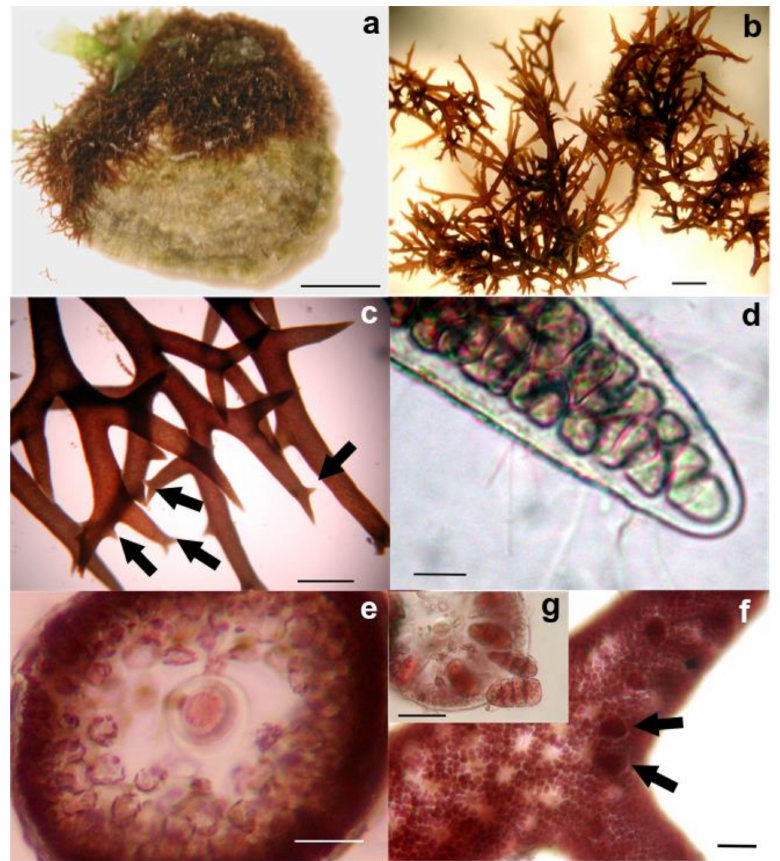
Figure4. Caulacanthusokamurae fromItaly. ( a )Specimen growing attachedona bivalveshell. ( b )General view of thalli. ( c ) Detail of a thallus showing the branching and the apexes (arrows). ( d ) Magnification of an apex. ( e ) Cross section. ( f ) Surface view of a tetrasporophytic thallus, showing tetrasporangia (arrows) formed mainly in the basal part of branches. ( g ) Cross section in proximity of tetrasporangia. Scale bars: ( a ): 1 cm; ( b ): 5 mm; ( c ): 500 µ m; ( d ): 10 µ m; ( e - g ): 50 µ